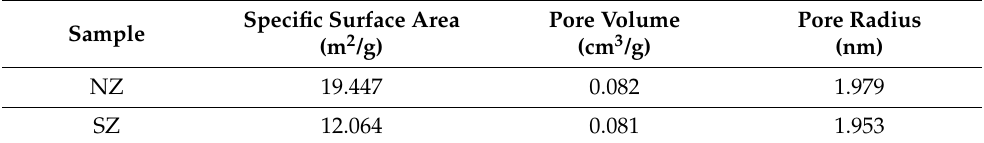
Table 4. The specific surface area, pore volume, and pore radius of NZ and SZ.